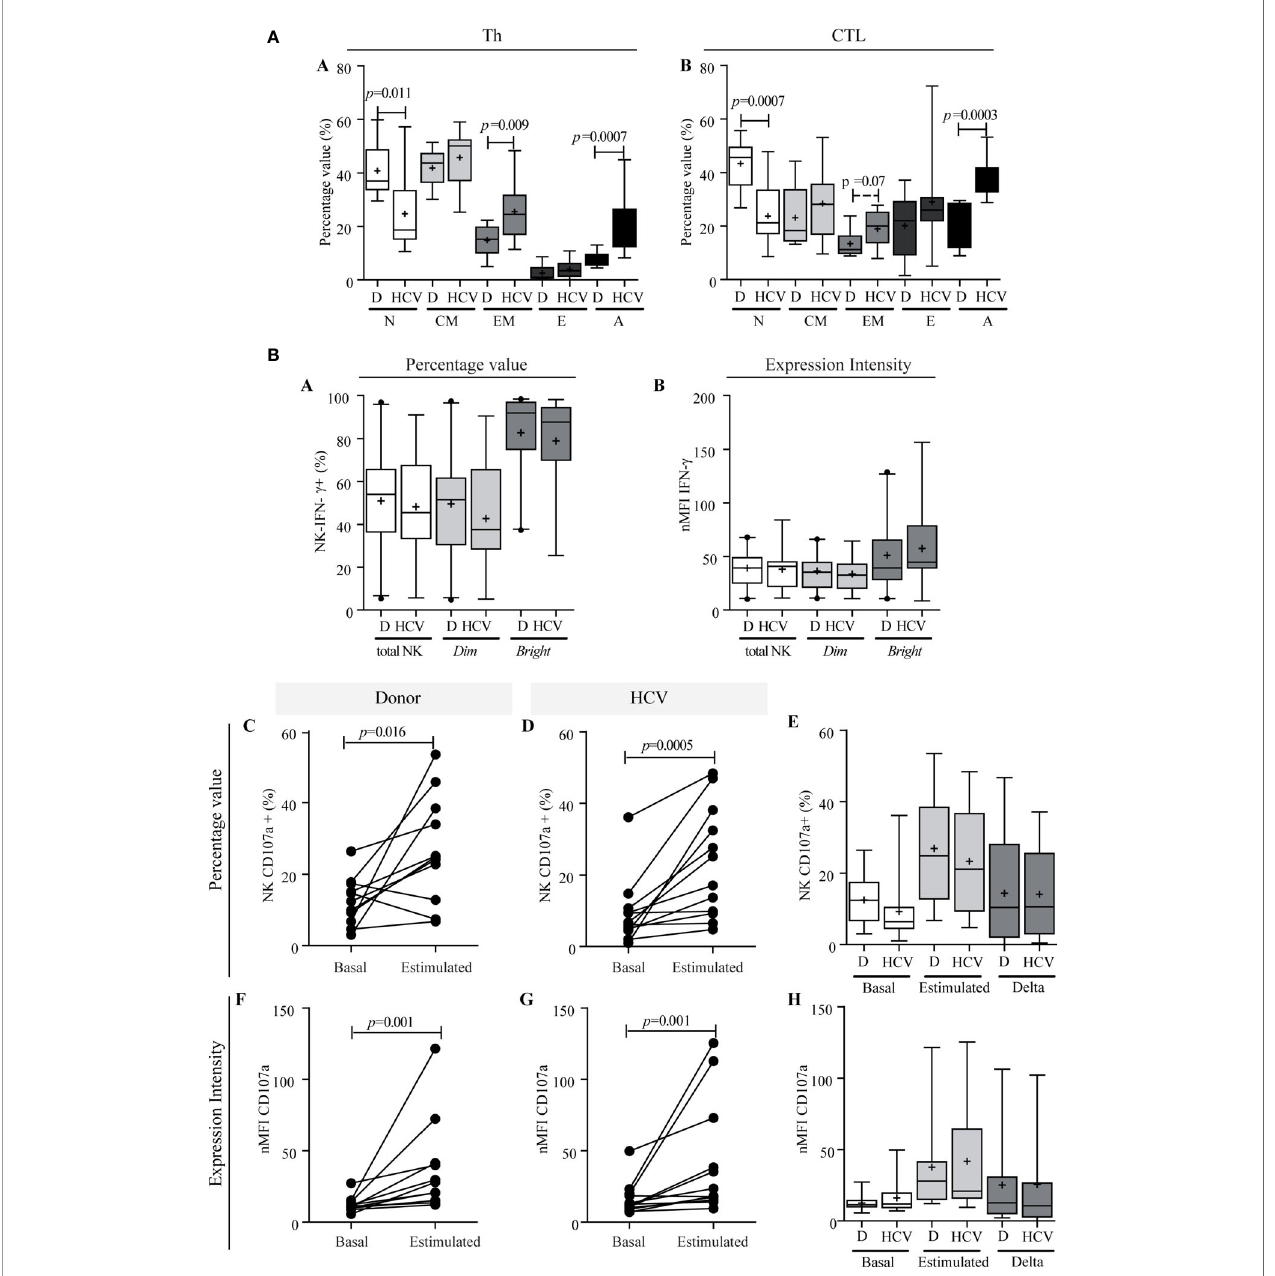
FIGURE 5 | T lymphocyte differentiation and functional characterization of NK cells. (A) Comparison of lymphocytes differentiation stages between donors and patients. Th (a) and CTL (b). Results are expressed as percentage values. N, naïve; CM, central memory; EM, effector memory; E, effector; A, activated. Student ’ s t-test was used to compare all data sets except for naïve Th and activated Th, and effector CTL for which Mann – Whitney U test was applied. Panel (B) IFN- g production capacity (a, b) and degranulation activity of NK cells (c – h). IFN- g production of NK cells in patients and donors (a, b). Percentage values (a), and intensity of expression (b). CD107a expression in total NK cells in percentage values (c – e) and in intensity of expression (f – h). Comparison of the response between basal conditions and before the stimulus per case in donors (c and f) and in patients (d, g). Comparison of basal CD107a expression in total NK cells, stimulated and magnitude of response (delta) between donor vs. patient (e and h). Results are expressed as percentage values (c – e) and intensity of expression (f – h). D, donor. When it corresponds, the results are depicted in box plots. Horizontal lines within boxes indicate medians. Horizontal lines outside the boxes represent the 5 and 95 percentiles. Mean is indicated as +. Mann – Whitney U test (a, b, e, h) and Wilcoxon test (c, d, f, g) were used to compare all data sets. The analysis of absolute values displayed similar results to the percentage values, but it is not shown to simplify their visualization